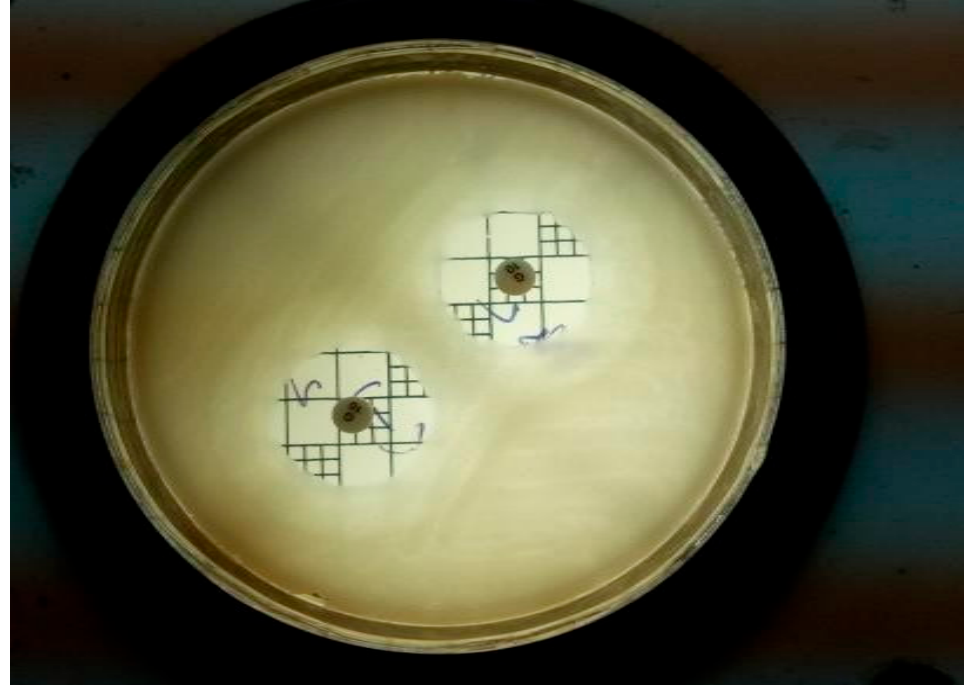
Figure 4. Standard Gentamycin on Staphylococcus aureus at 10mcg in duplicate at ZOI of 22.2 mm.